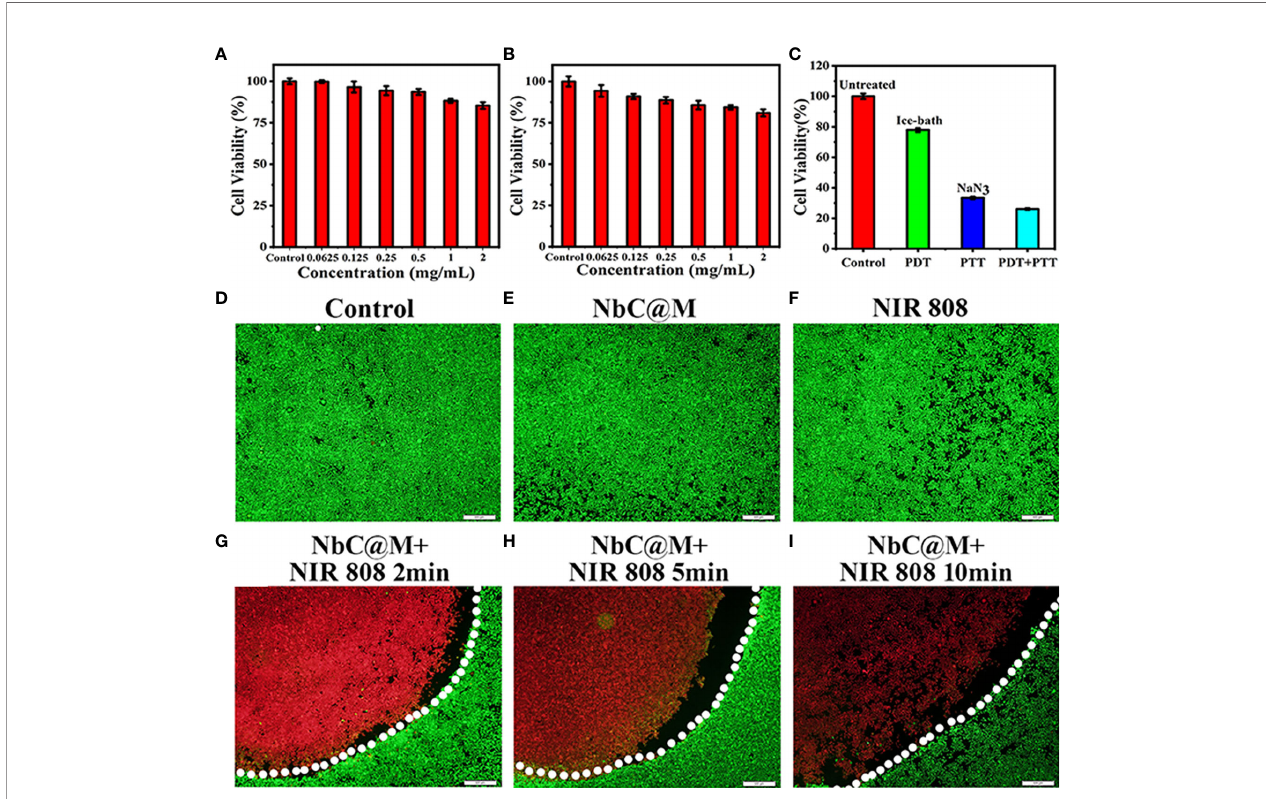
FIGURE 4 | In vitro cell cytotoxicity assay and phototherapeutic effect of NbC@M nanoparticles. Relative cell viability of HepG2 cells treated with different concentrations of NbC@M nanoparticles for 12h (A) and 24h (B) . (C) Relative cell viability after different treatments with NbC@M nanoparticles. (D – I) Fluorescence images of Live/dead HepG2 cells after receiving different treatments (808 nm, 1W/cm 2 , 10 min; scale bar = 500 m m).